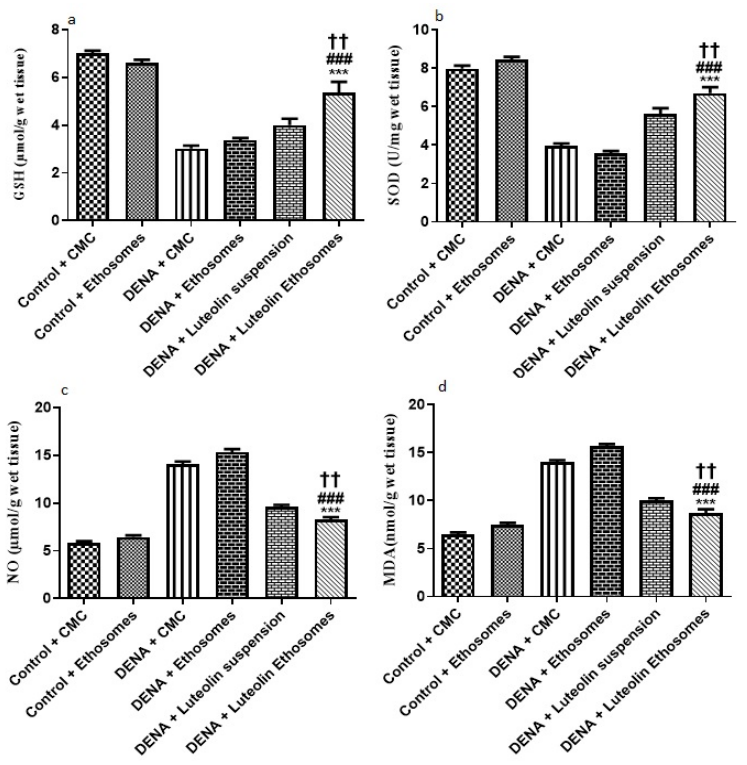
Figure 9. Effects of LUT and/or LUT-ENPs on, ( a ) glutathione (GSH), ( b ) superoxide dismutase (SOD), ( c ) nitric oxide (NO), and ( d ) malondialdehyde (MDA). Data are presented as mean ± SEM ( n = 12). *, # and † indicate significant changes from control, DENA, and DENA+ Luteolin suspension groups respectively. †† indicates significant change at p < 0.01; *** and ### indicate significant change at p < 0.001.